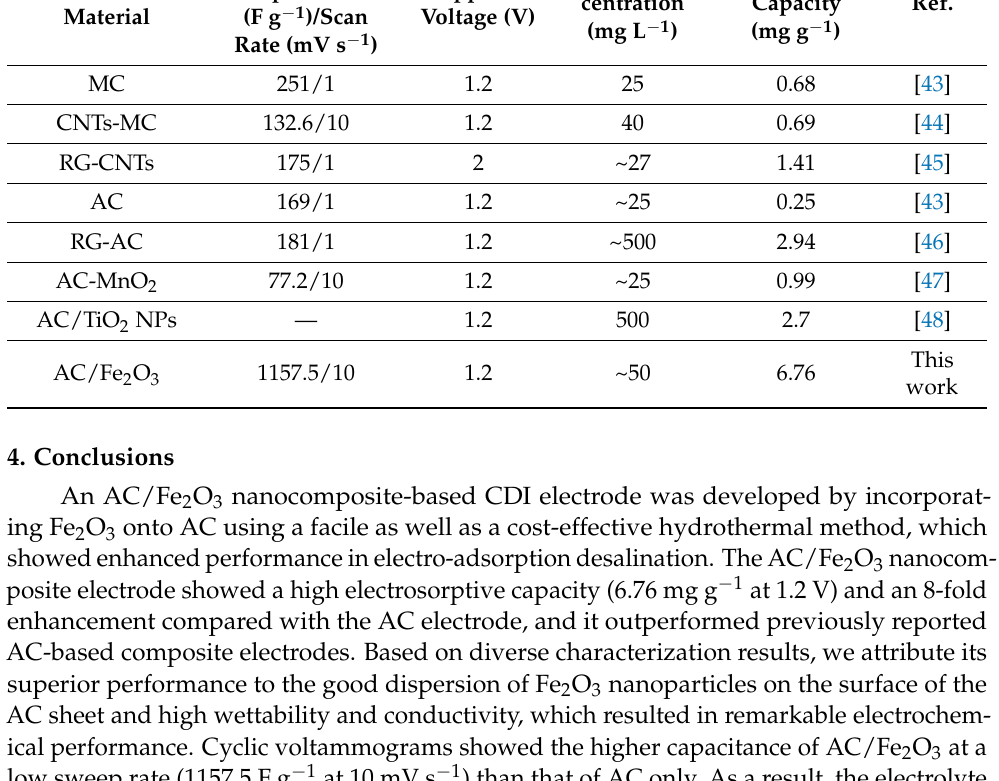
Figure 7. ( a ) CDI profiles, ( b ) electrosorption capacity for the fabricated electrodes. Table 3. The specific capacitance and electrosorption capacity for different carbon-based electrodes. Electrode Ma-